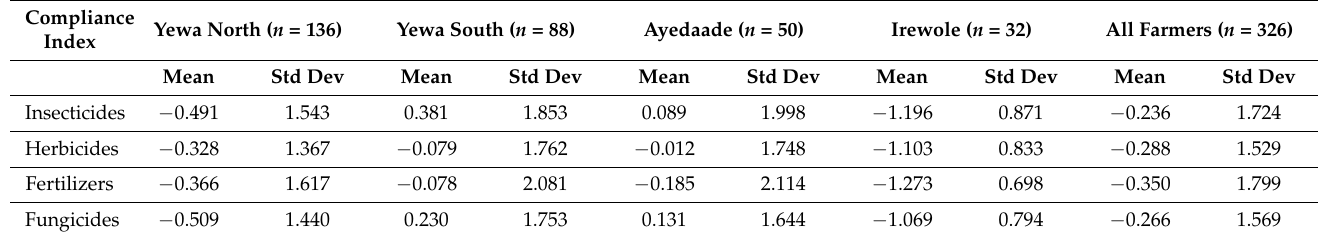
Figure 3. Distributional kernel density graphs of agrochemical safety indicators. Table 3. Descriptive statistics of cocoa farmer indicators of agrochemical safety compliance.